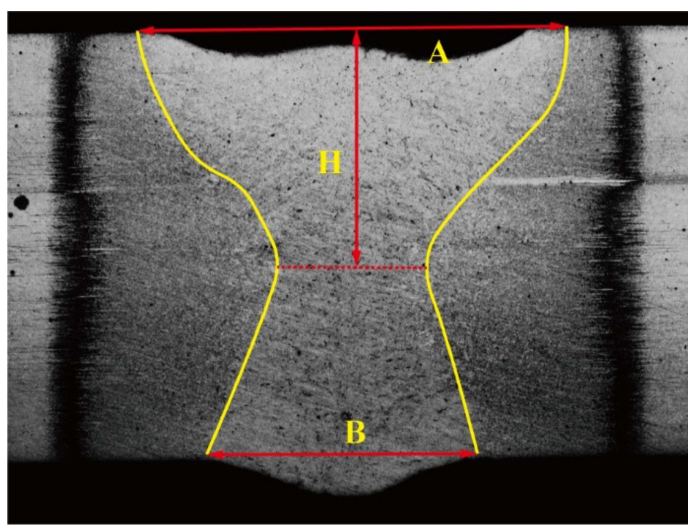
Figure 12. Schematic diagram of the parameters of weld shape.